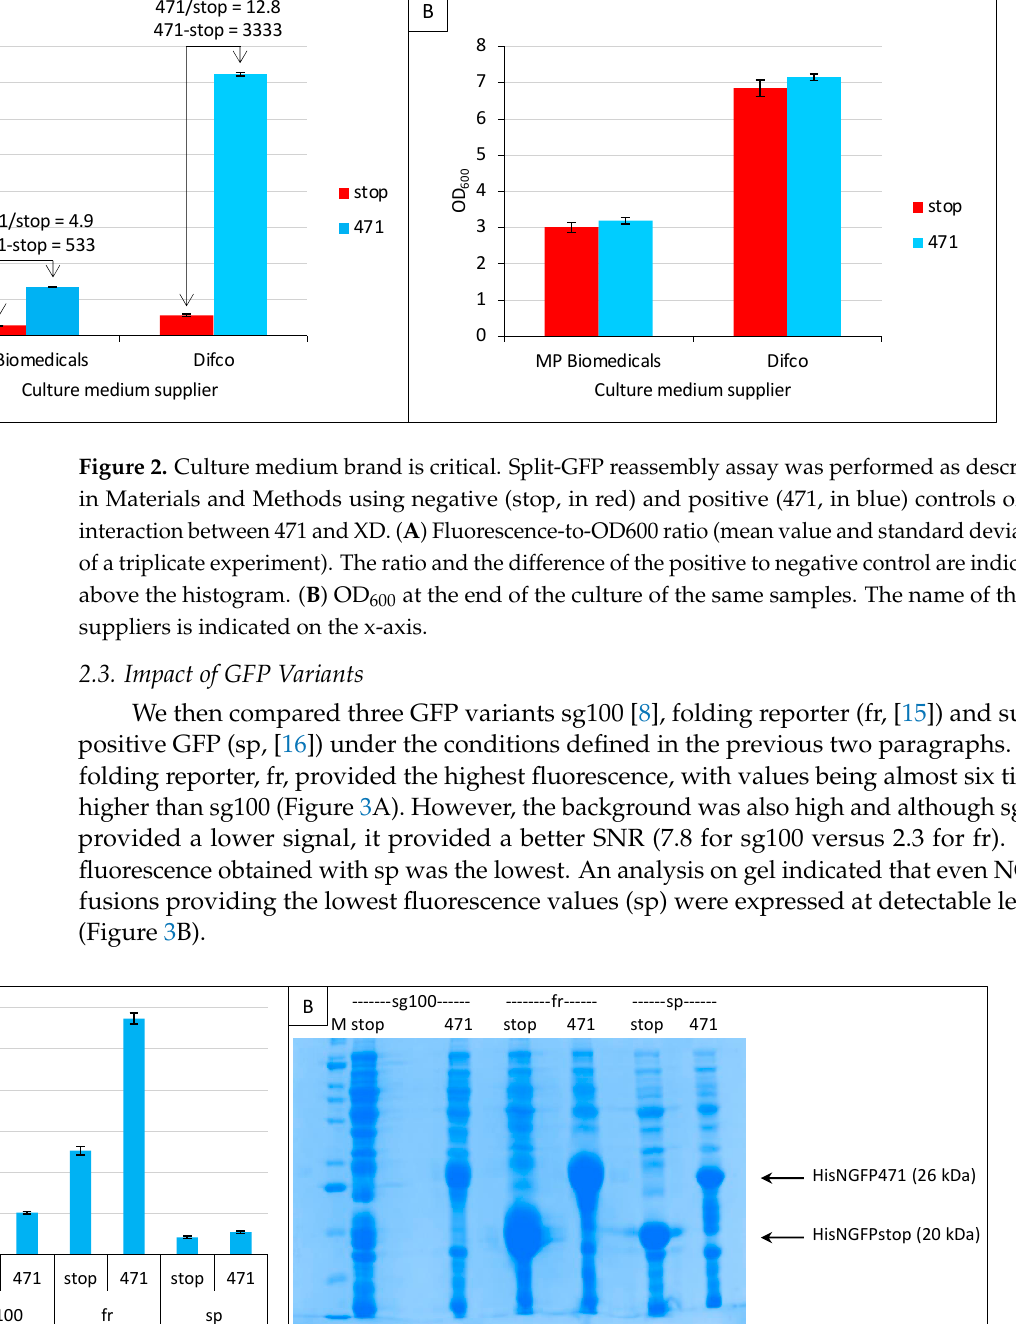
Figure 3. Comparison of sg100, fr and sp GFP variants at a single temperature. Split-GFP reassembly assay results as obtained with the negative (stop) and positive (471) controls of the 471/XD interaction with sg100, fr and sp GFP reporters at 17 °C. ( A ) Fluorescence to OD 600 ratios. ( B ) SDS-PAGE analysis of the expression of the NGFP fusions. M, molecular size markers (200, 150, 100, 85, 60, 50, 40, 30, 25, 20, 15, 10 kDa).